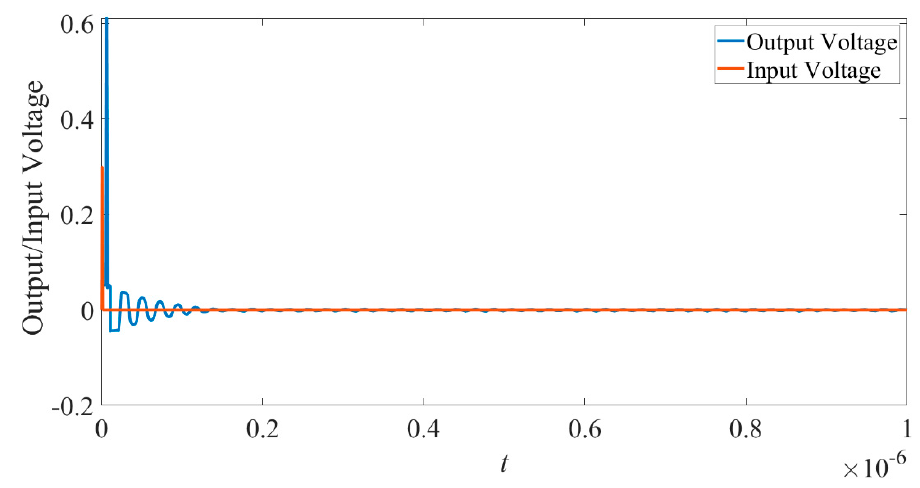
Figure 11. Superthreshold response of the neuristor.